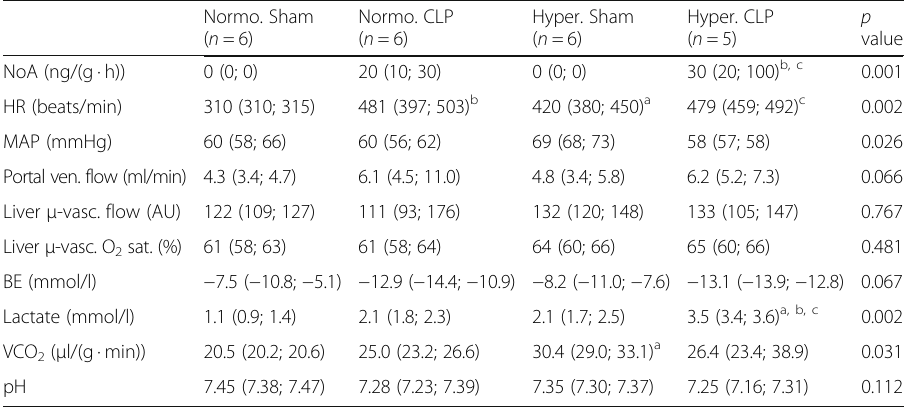
Table 1 Physiological data